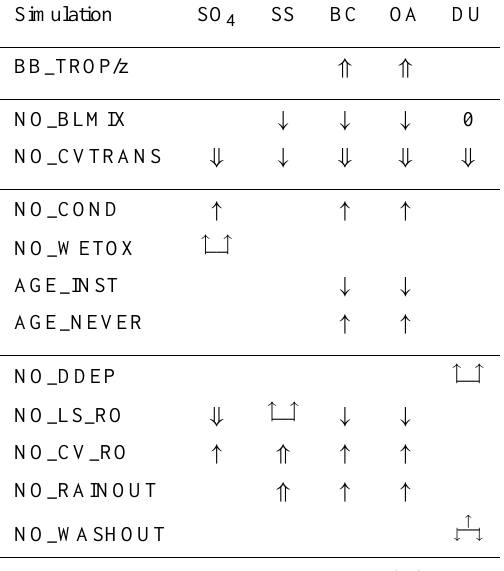
Table 3. HadGEM3–UKCA simulations showing the strongest change (compared to BASE) in zonal-mean vertical centre of mass. Simulation SO 4